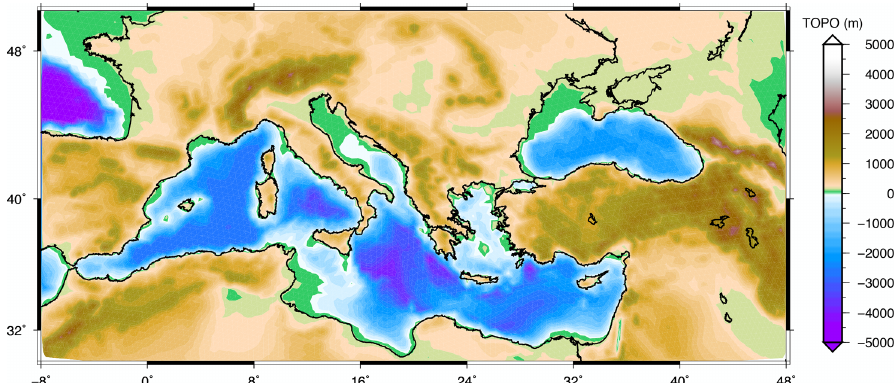
Figure 6. Paleotopography of the Mediterranean Sea and the Black Sea at 26ka, obtained by a high-resolution SELEN 4 run with configura- tion R100/L512/I5 , in order to highlight the exposed lands in